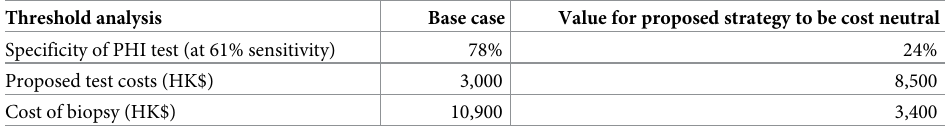
Table 5. Threshold